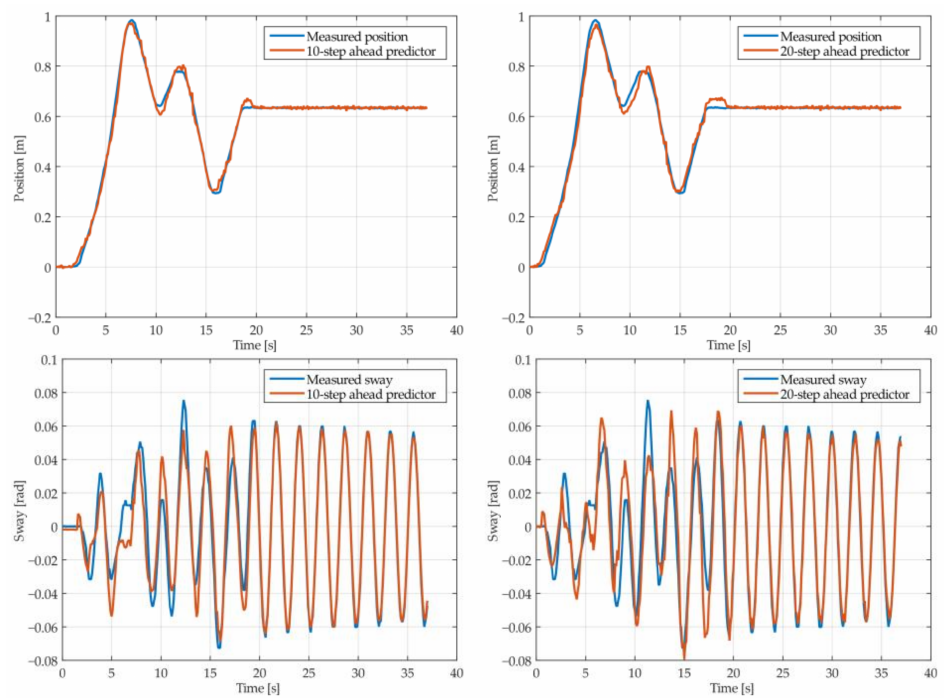
Figure 14. The 10- and 20-step ahead prediction with the MGGP model of the experimental crane position and payload sway with 0.9-meter rope and 40 kg payload mass.